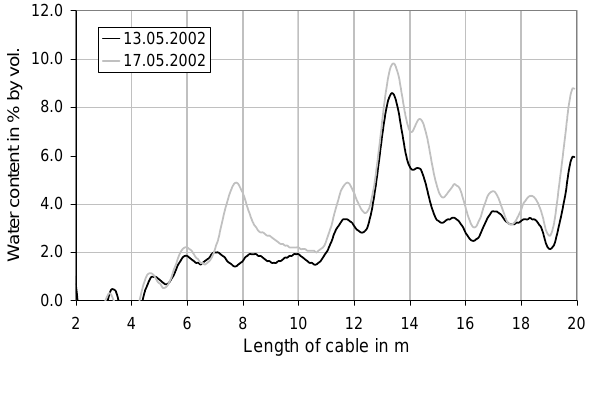
Figure 14. Spatial variation of LWC along the upper horizontal cable at two days during the melting period.